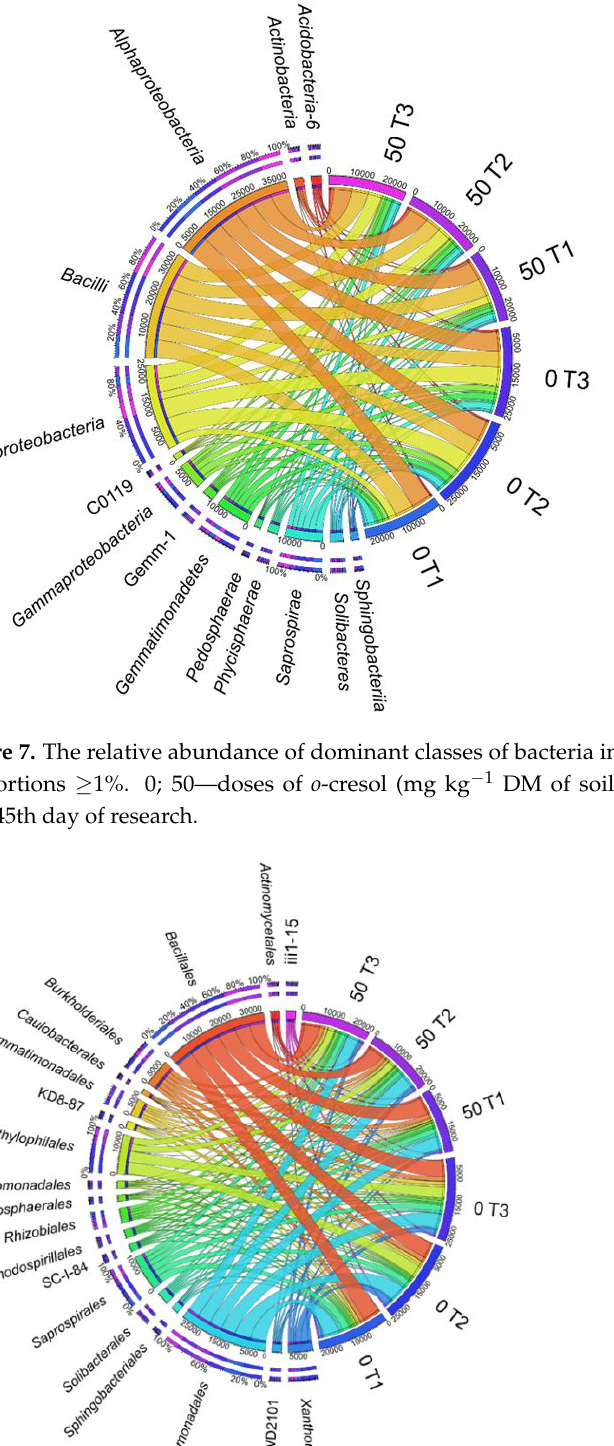
Figure 9. The relative abundance of dominant family of bacteria in soil with a difference between proportions ≥1%. 0; 50—doses of o -cresol (mg kg −1 DM of soil); T1—15 th day, T2—30 th day, T3—45 th day of research.